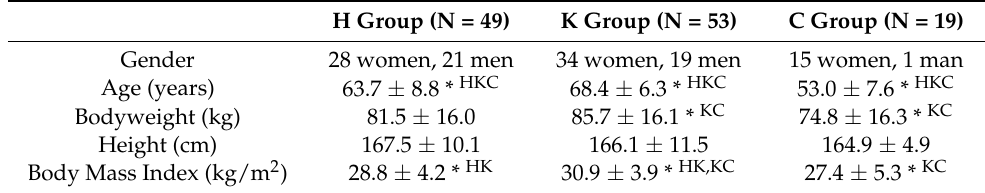
Table 1. Mean ± standard deviation of anthropometric data of H-, K- and C